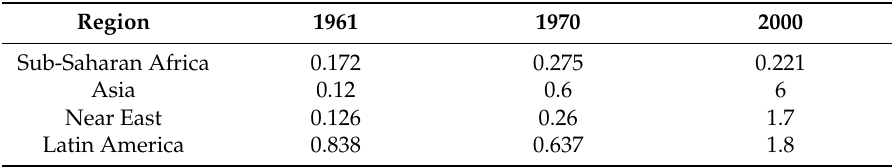
Table 5. Tractor populations in different regions from 1961 (millions of units). Region